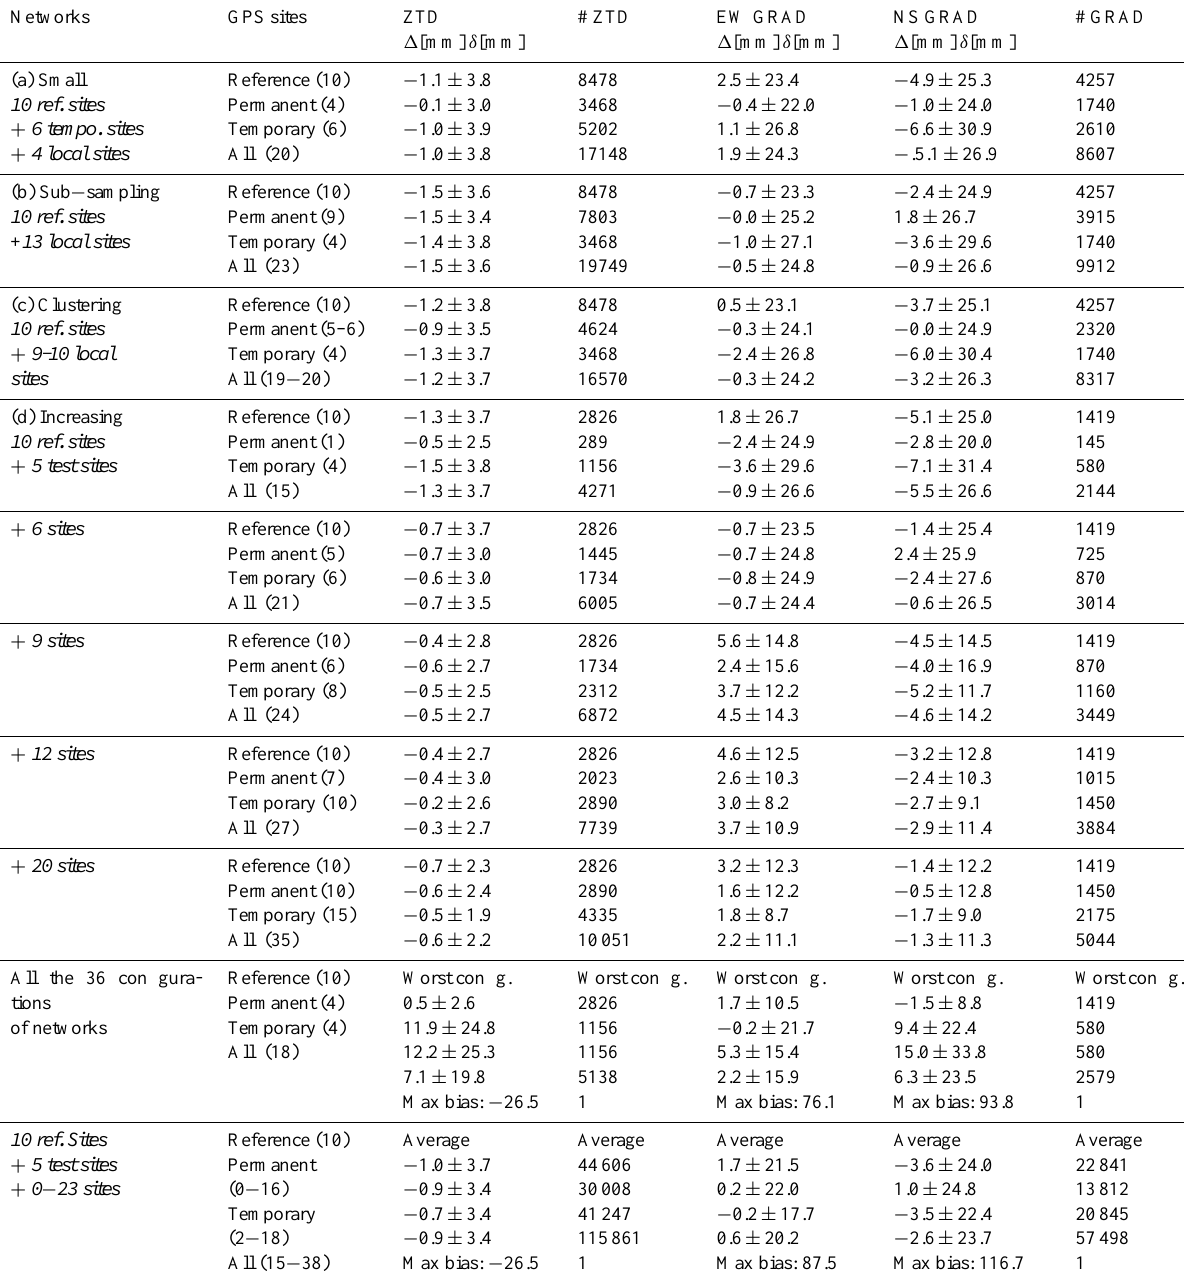
Table A1. Bias ( 1) and standard deviation ( δ) of ZTD and GRAD evaluations (EW and NS components) of sub-networks with respect to the reference network. Statistical results are shown for 10 widely spread reference stations, the permanent stations, the temporary stations of our dense network, and for all the stations. The number of ZTD and GRAD evaluations entering in the statistics are indicated, and maximum biases over all tests are shown in the last two